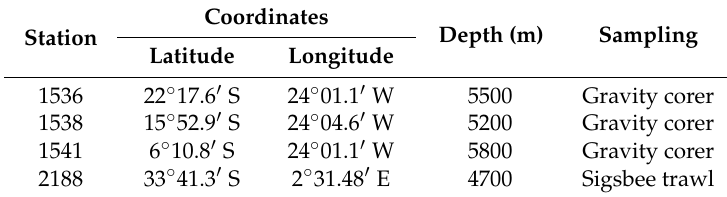
Table 1. Coordinates, water depth, and exploration tools used for sampling.